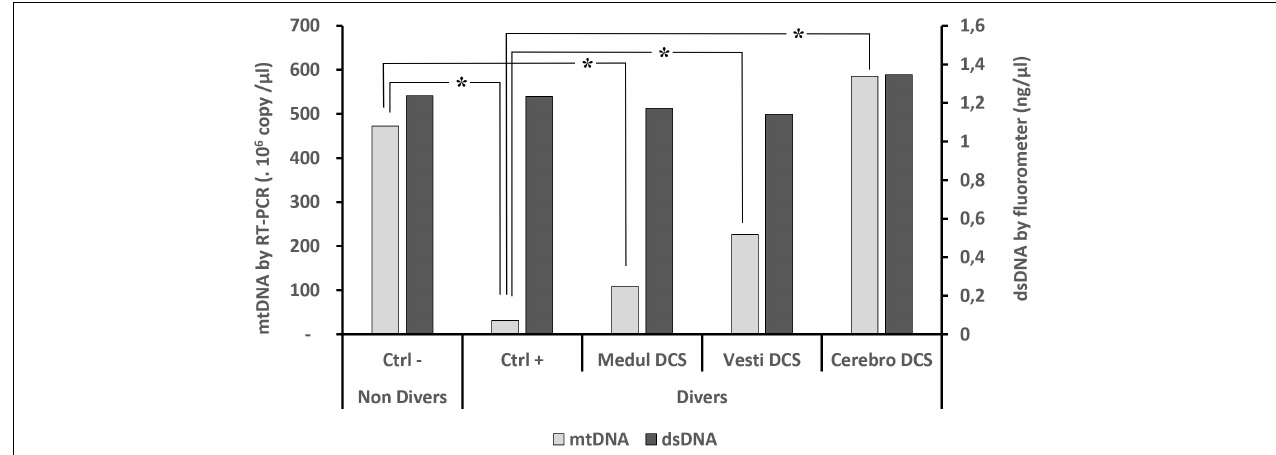
FIGURE 1 | Circulating oligonucleotides according to clinical diagnosis. Quantifications of oligonucleotides were performed (1) (black histograms) by direct fluorometric measurement targeting the double strands of DNA without distinction, after the double centrifugation, and then (2) by RT-PCR (gray histograms) including the double centrifuging before the extraction/purification phase, which was followed by a qPCR targeting mDNA. Asterisk ( ∗ ) notes a significant difference, or µ a trend, in the KW ( n = 114) post hoc analysis ( p < 0.05).